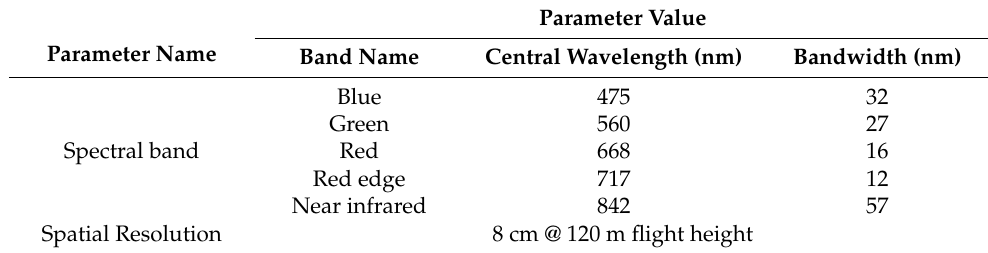
Figure 3. UAV remote sensing image data acquisition system. Table 1. Part of the parameters of the multispectral